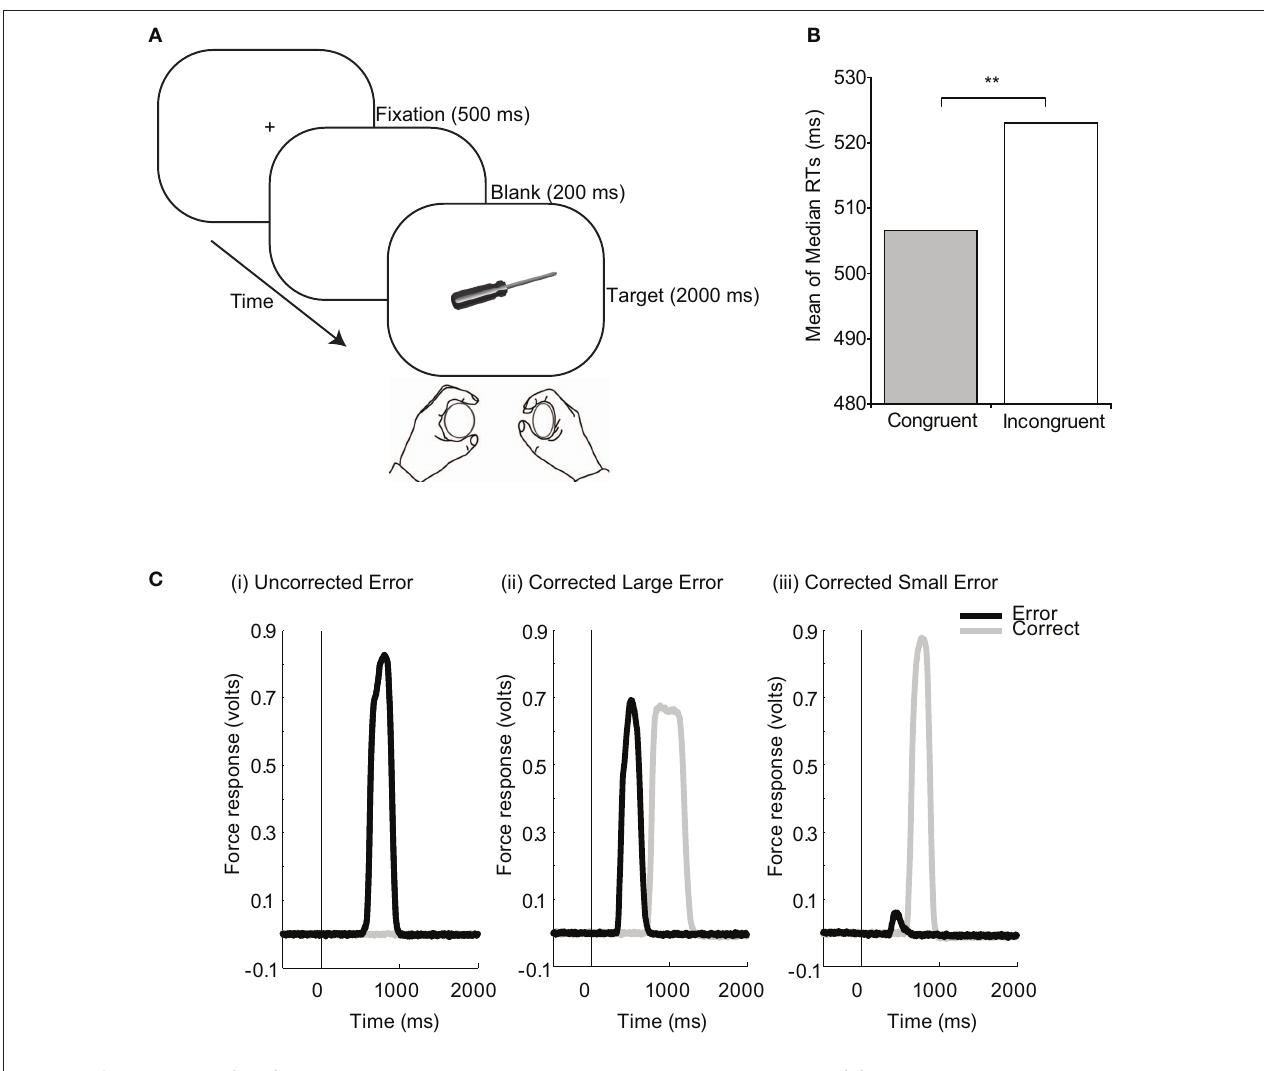
FIGURE 1 | McBride et al. (2012) studied automatic priming of motor responses by visual objects in an object affordance task. Here, participants made speeded squeeze responses with either their left or right hand according to whether the object presented on each trial belonged in a kitchen or a toolbox (see A for task details). The objects could also afford a grasping action with either the left or right hand. Although object affordance was irrelevant to the task, it still modulated responses so that they were faster when the object afforded a congruent response